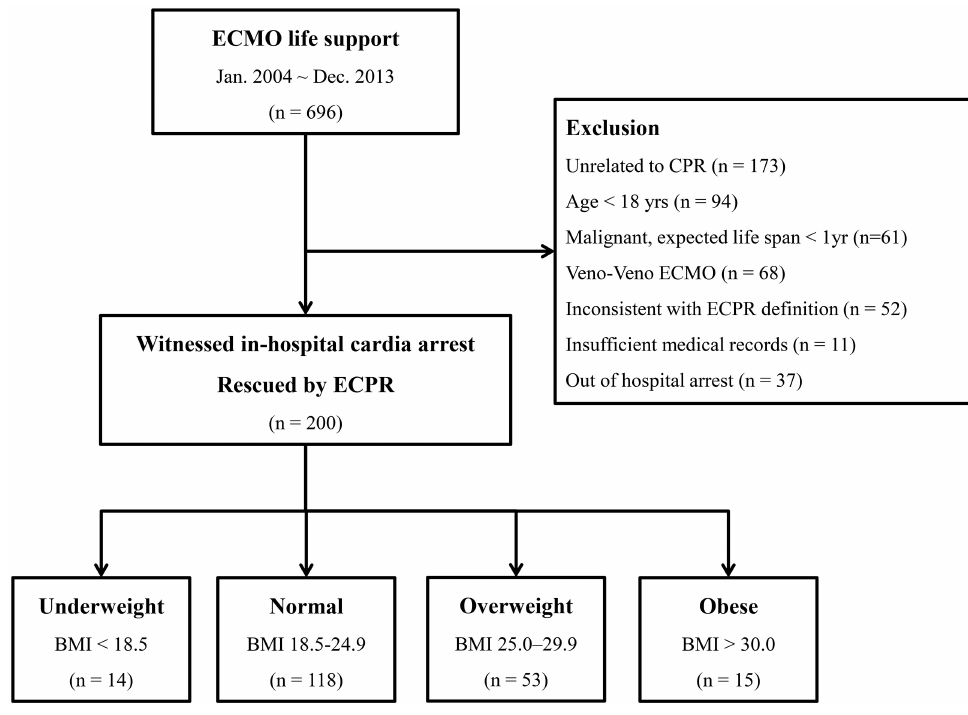
Fig 1. Scheme of group distribution in the